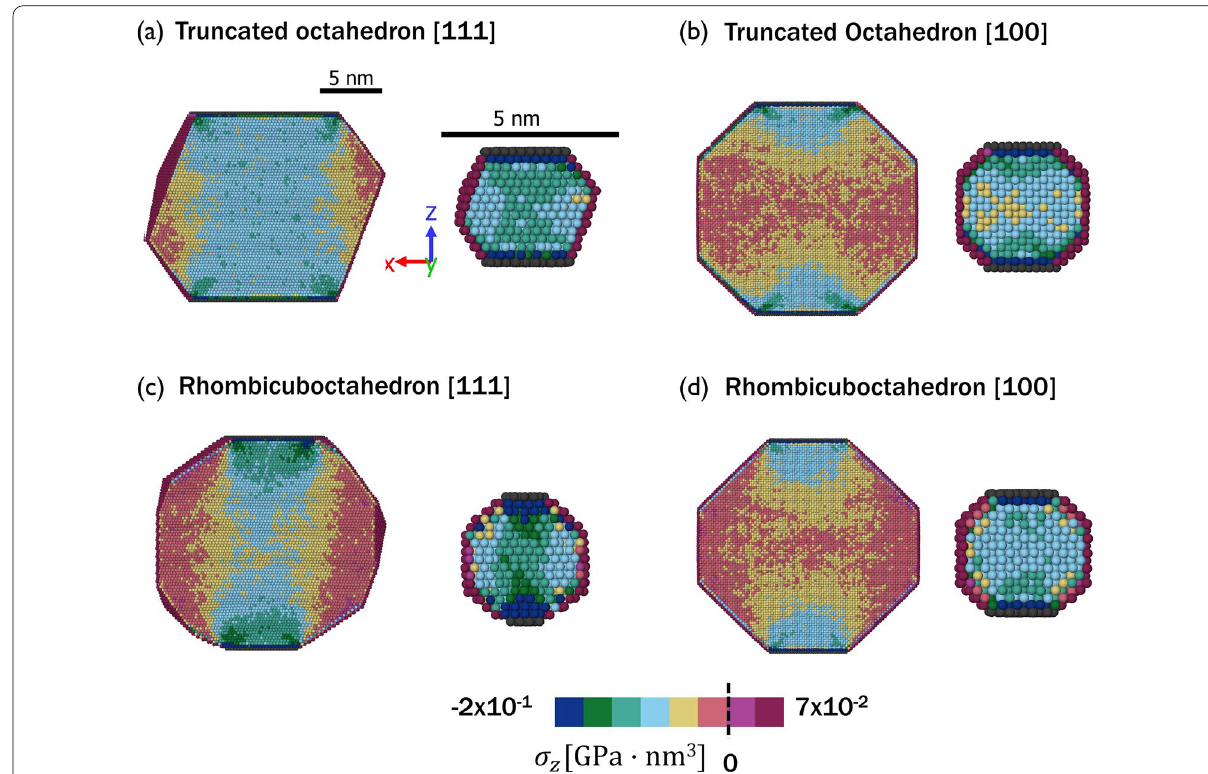
Fig. 3 Virial stress distributions for 20 nm and 4 nm nanoparticles. Virial stress on cross-sections parallel to the loading direction for the two nanoparticle shapes, a , b truncated octahedron and c , d rhombicuboctahedron, and two crystallographic orientations, a , c correspond to {111} and b , d to {100} orientation. The color scale has units of GPa · nm